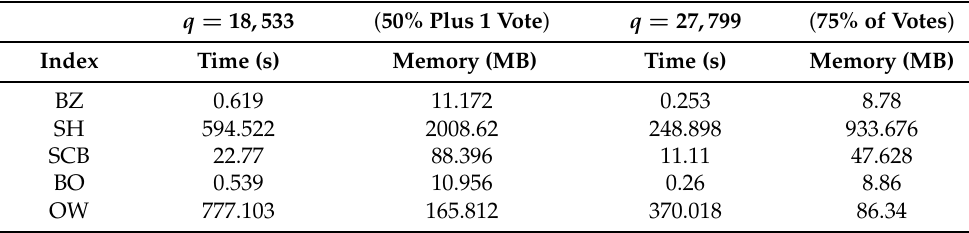
Table 1. Computing times and memory requirements for an example with 741 players, ˜ w = 37,064, 40 precoalitions, a maximum coalition size of 40 and an average coalition size of 18.